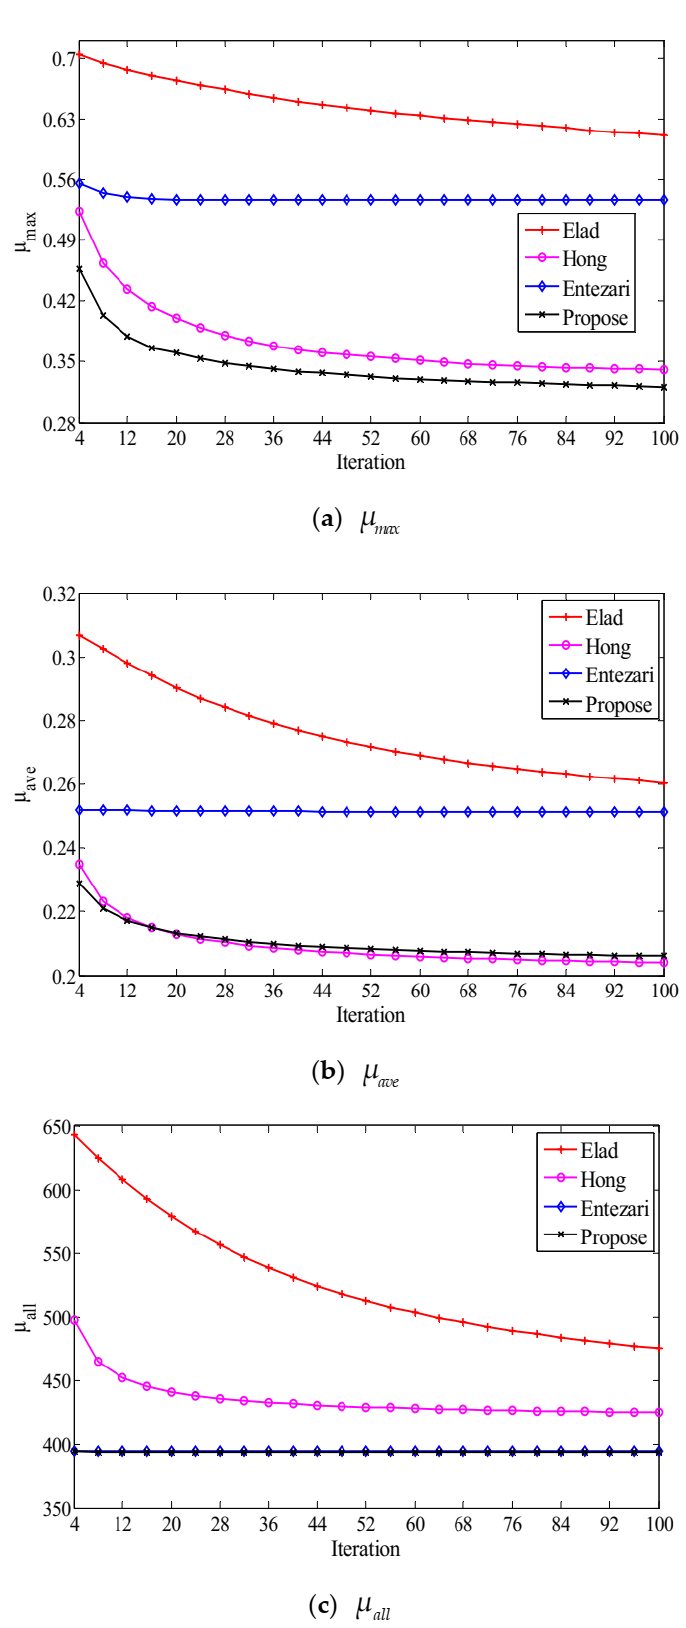
Figure 2. The convergence results: ( a ) evolution of µ max , ( b ) µ ave and ( c ) the evolution of µ all , all versus iteration number, where M =